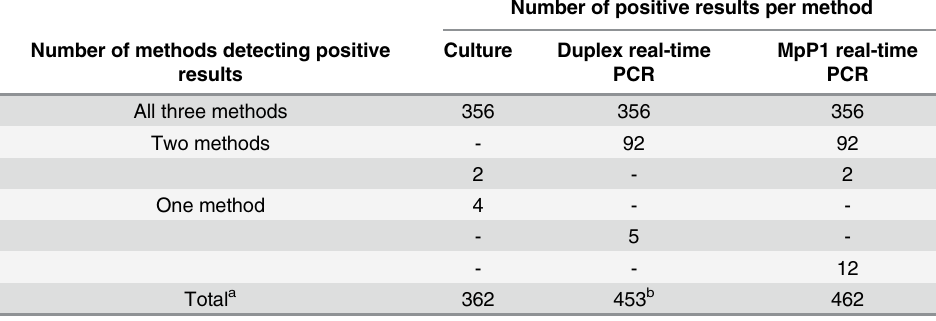
Table 5. Positive results for M . pneumoniae in clinical specimens detected by culture and real-time PCR